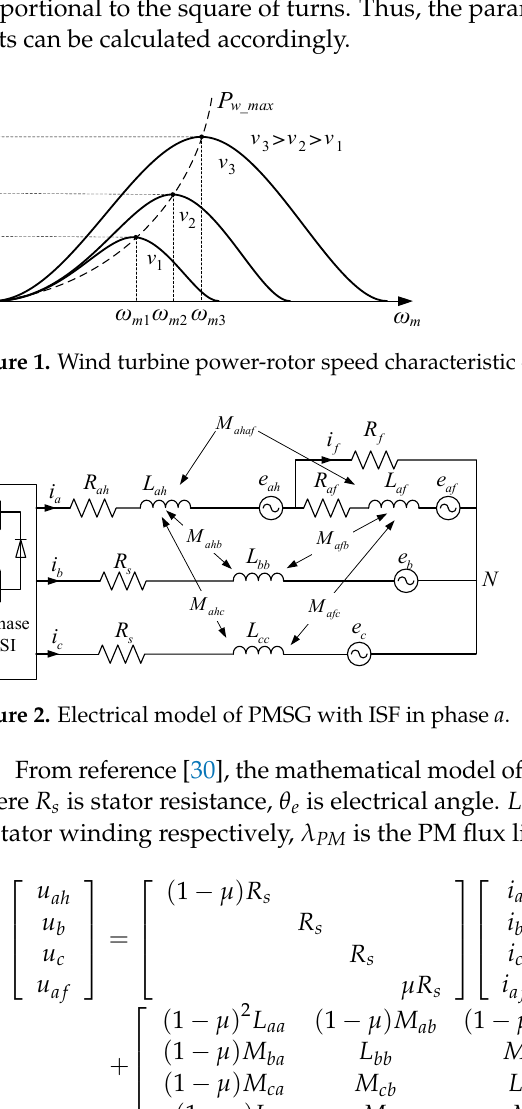
Figure 1. Wind turbine power-rotor speed characteristic curves at different wind speeds.